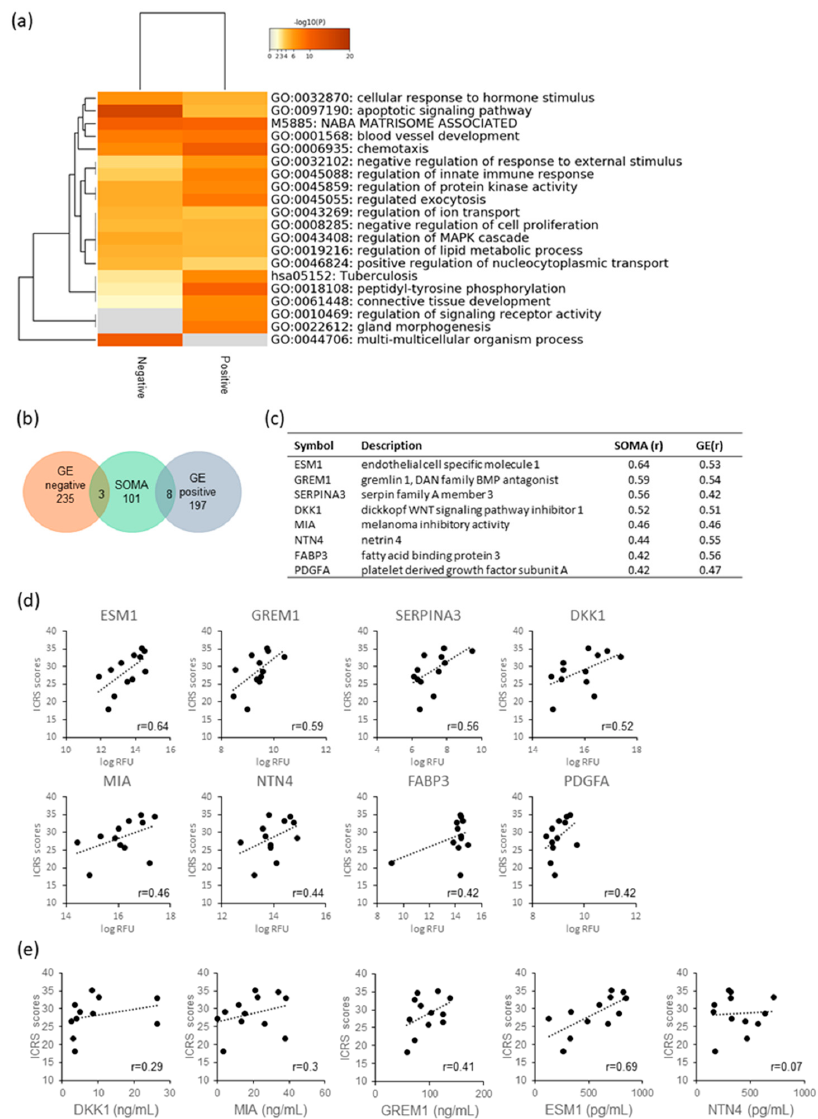
Figure 5. Analysis of proteins secreted by PD sheets: ( a ) Meta-enrichment analysis of selected proteins. ( b ) Venn diagram of genes selected from the microarray and SOMA scan assay. ( c ) List of genes exhibiting positive correlation in both mRNA expression (GE) and protein secretion (SOMA). ( d ) Scatterplots between ICRS score and relative protein amount for supernatants of the PD sheets as examined by SOMAscan (log10 relative fluorescence unit: logRFU). ( e ) Scatterplots between ICRS score and protein concentration as determined by ELISA.